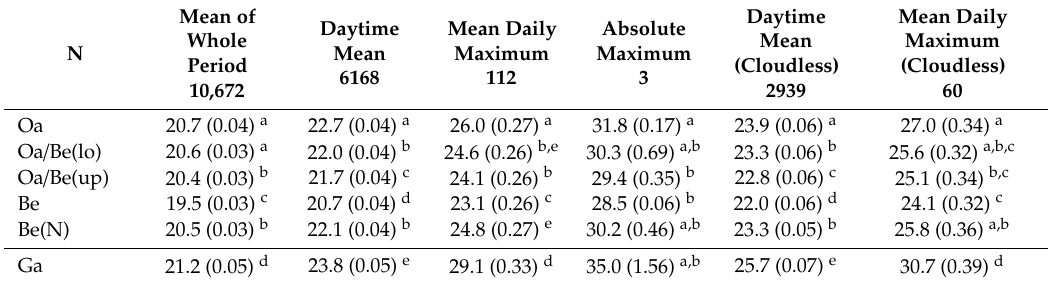
Table 3. Mean air temperatures (in ◦ C), mean daytime temperatures, mean daily maxima, and mean absolute maxima (with SE in brackets) at the five measuring points in the forest and in the gap, averaged over the three transects. The daytime period refers to 9 a.m.–9 p.m. Significantly di ff erent means are marked with di ff erent small letters. The first four columns refer to all days of the measuring period, the last two columns only to days with less than 50% cloudiness and no rain (cloudless). N gives the number of individual 15-min values used for